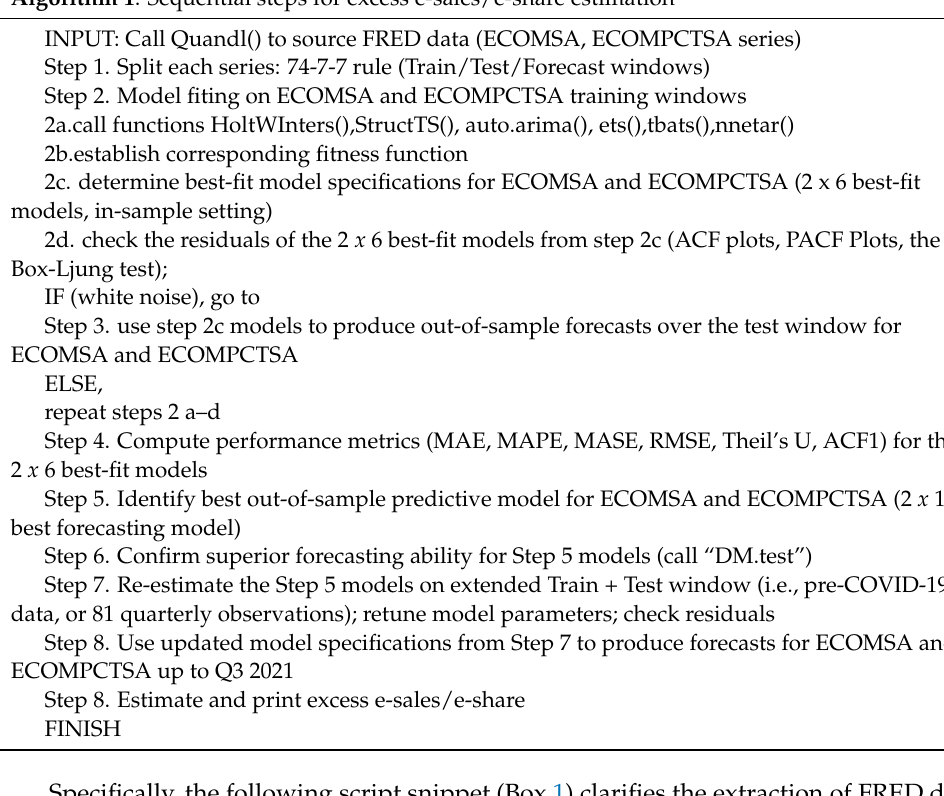
Algorithm 1 . Sequential steps for excess e-sales/e-share